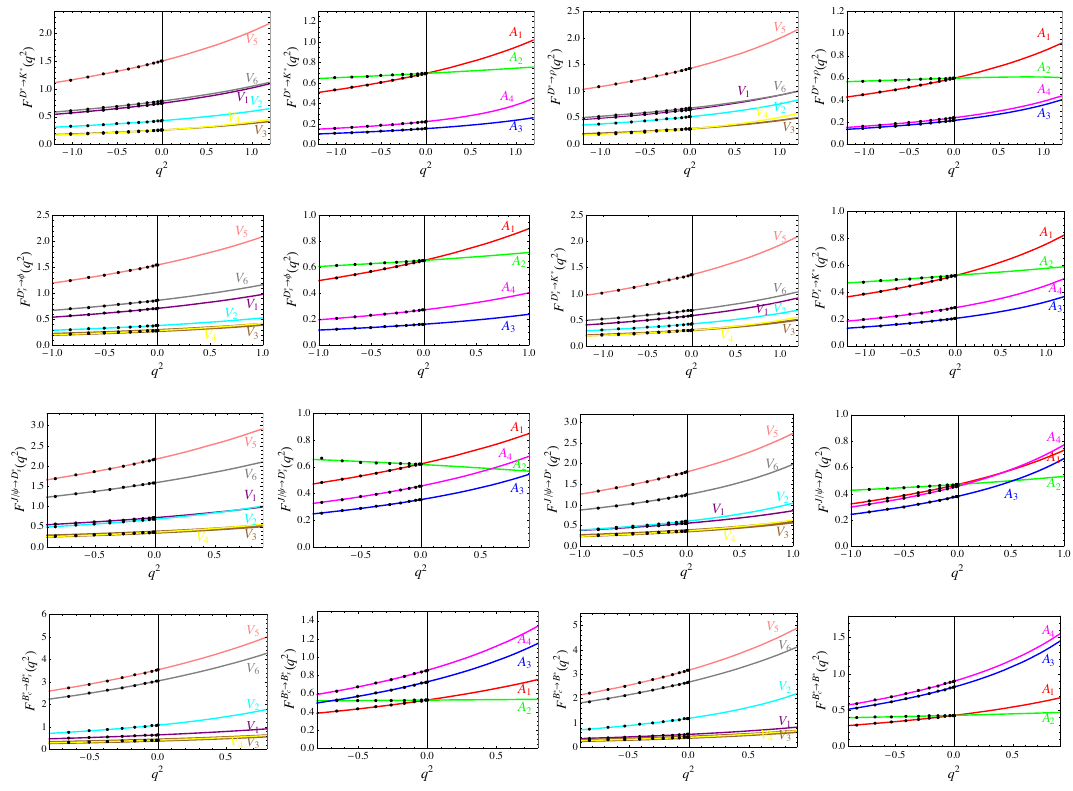
Figure 3 . q 2 (in unit of GeV 2 ) dependence of form factors of c ! ( s; q ) induced D (cid:3) ! ( K (cid:3) ; (cid:26) ), D (cid:3) ! ( (cid:30) ; K (cid:3) ), J= (cid:9) ! ( D (cid:3) ; D (cid:3) ), B (cid:3) ! ( B (cid:3) ; B (cid:3) ) transitions with the parameterization scheme s s c s given by eq. (4.16). The dots in the space-like region are the results obtained directly via LFQMs, and the lines are (cid:12)tting